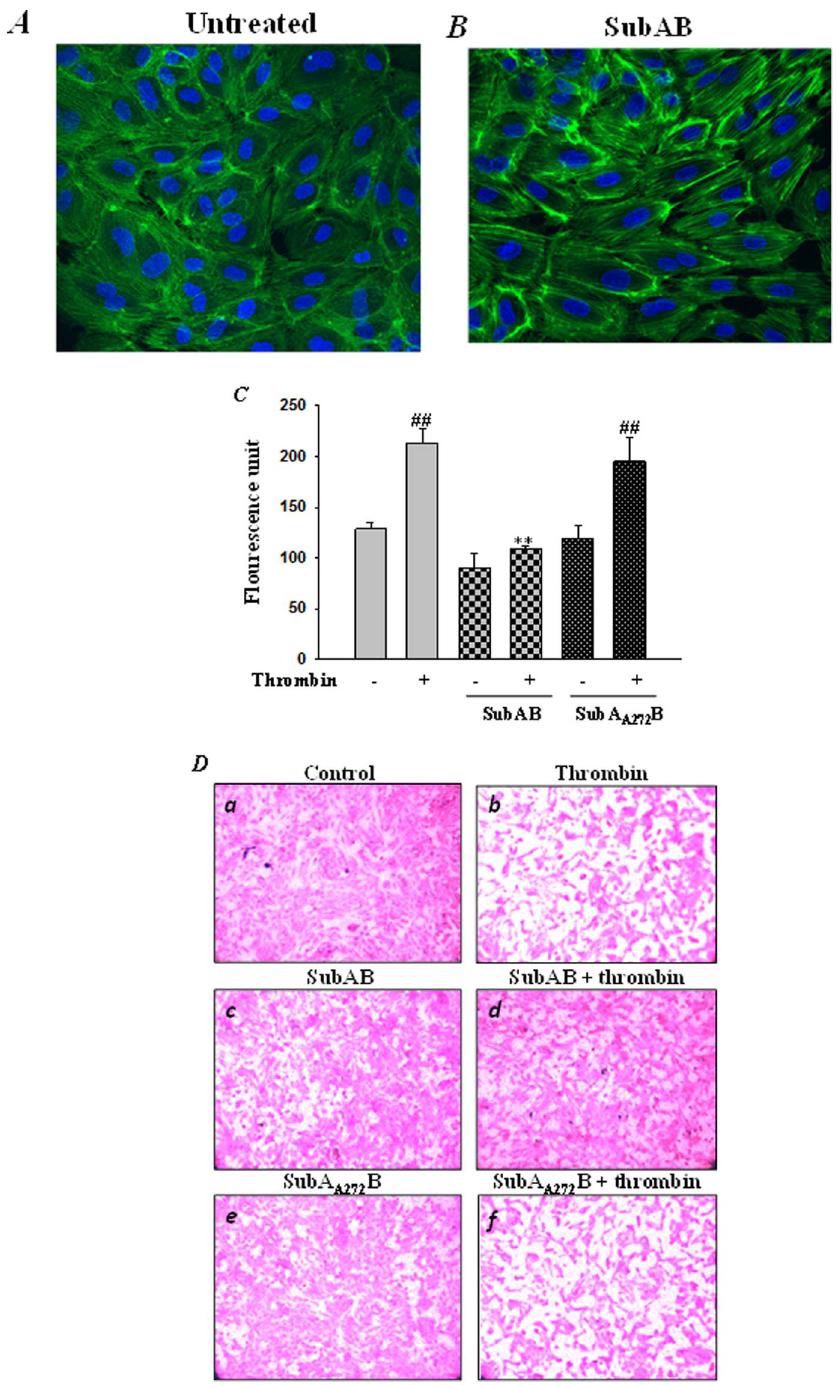
Figure 14. SubAB potentiates actin filament formation and regulates thrombin-induced endothelial permeability. HPAEC were left untreated ( A ) or ( B ) treated with 0.1 m g/ml of SubAB for 6 hours. The cells were then fixed, permeabilized, and stained with Alexa Fluor 488 labeled phalloidin to visualize the actin filaments. Images were analyzed by Fluorescence microscopy. Results are representative of three experiments. ( C ) HPAEC treated with 0.1 m g/ml of SubAB or mutant SubA A272 B for 6 h were seeded at 20,000 cells per transwell insert and cultured for 48 hours. Following this, the confluent monolayer was treated with thrombin (5 U/ml) for 30 minutes. FITC-Dextran permeability testing was done to check monolayer integrity. Permeation was stopped by removing the inserts from the wells. Media from the receiver tray was transferred to a 96 well opaque plate to measure fluorescence. Fluorescent intensities were quantified using a fluorescent plate reader with filters appropriate for 485 nm and 535 nm excitation and emission. The data are the means 6 S.E. (n=3–6 for each condition). ## p , 0.01 difference from controls; ** p , 0.01 difference from thrombin stimulated controls. ( D ) Following permeability testing the endothelial monolayer representing various experimental conditions (as indicated in the Figure) was stained for bright field imaging.